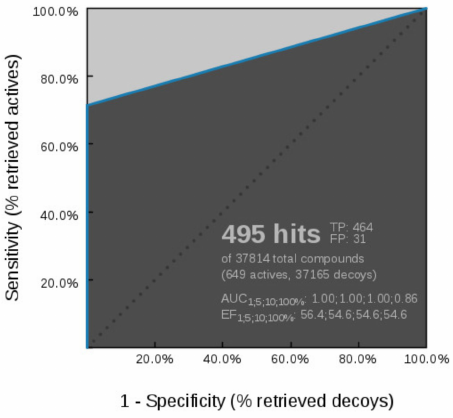
Figure 11. Receiver operating characteristic (ROC) curve resulting from parallel virtual screening of the Hsp90 active and decoy datasets with 13 Hsp90 inhibitor 3D-pharmacophore models. The parallel screening approach gives a high coverage of Hsp90 inhibitor active space while maintaining an acceptable false-positive